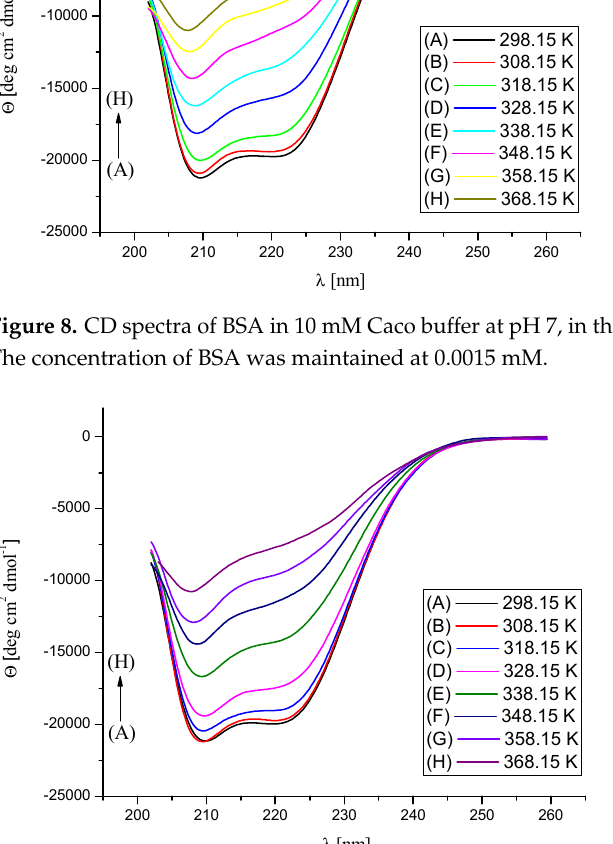
Figure 9. CD spectra of the Na[B(Ph) 4 ]/BSA mixture (Na[B(Ph) 4 ]:BSA = 2.5:1 molar ratio) in 10 mM Caco buffer at pH 7, in the temperature range 298.15–368.15 K. The concentration of BSA was maintained at 0.0015 mM.